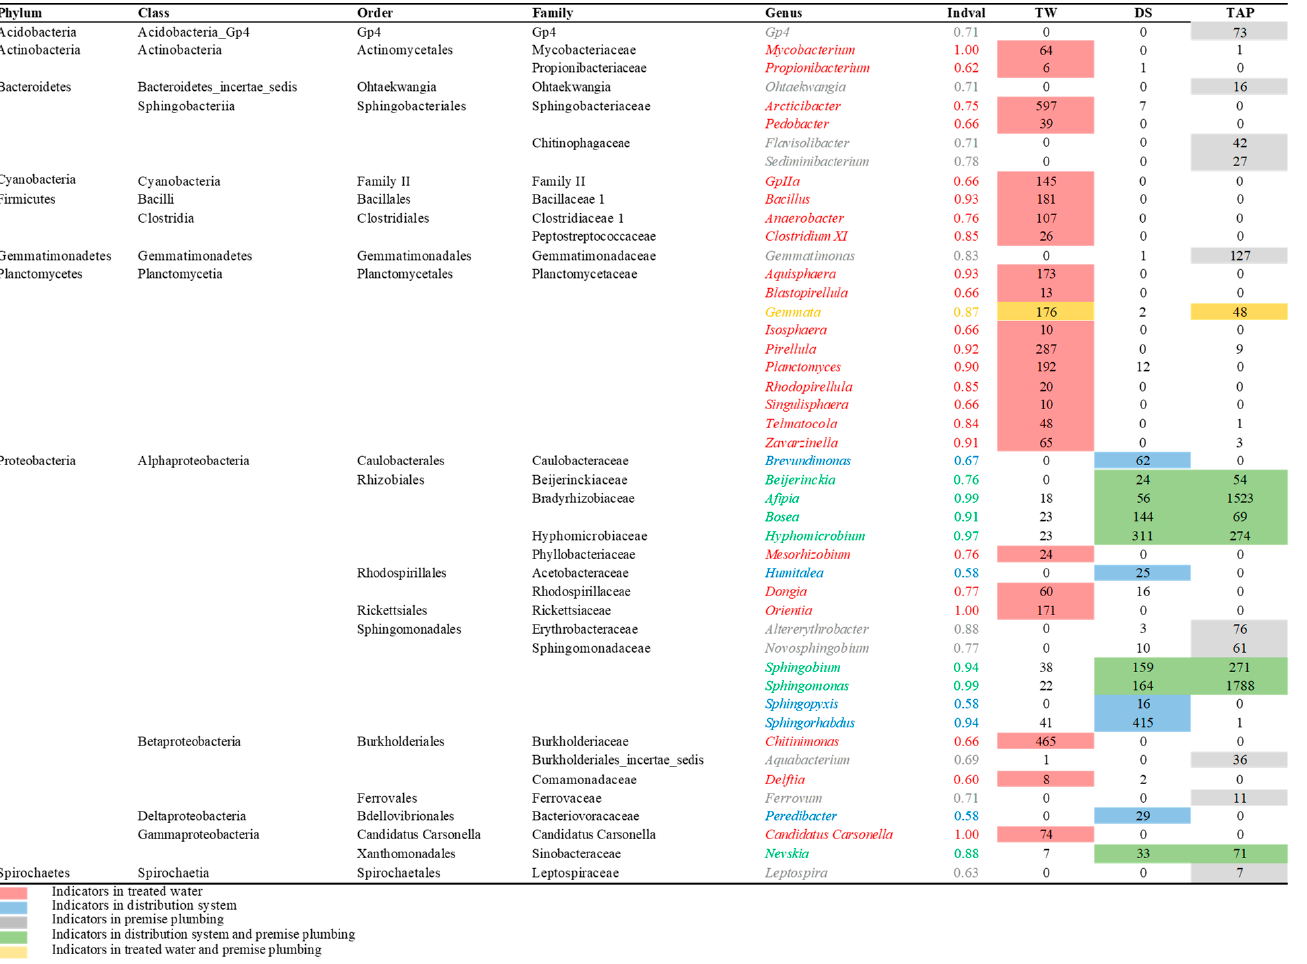
Table 2. Number of sequences of indicator species (at genus level) in treated water, distribution system, and taps from premise plumbing ( α = 0.05).